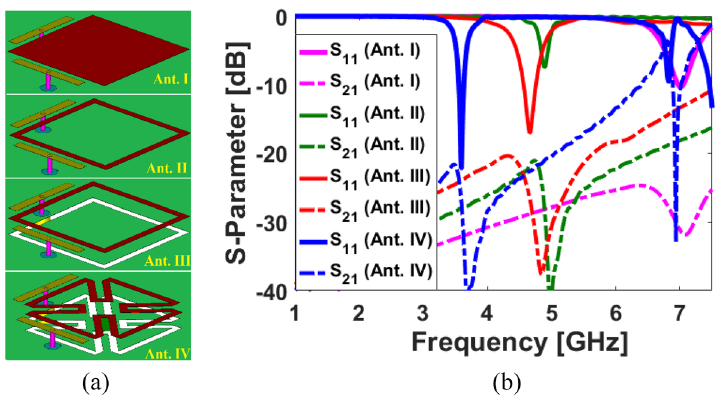
Figure 2. ( a ) Evaluation and ( b ) S-parameter investigation of SCA element.